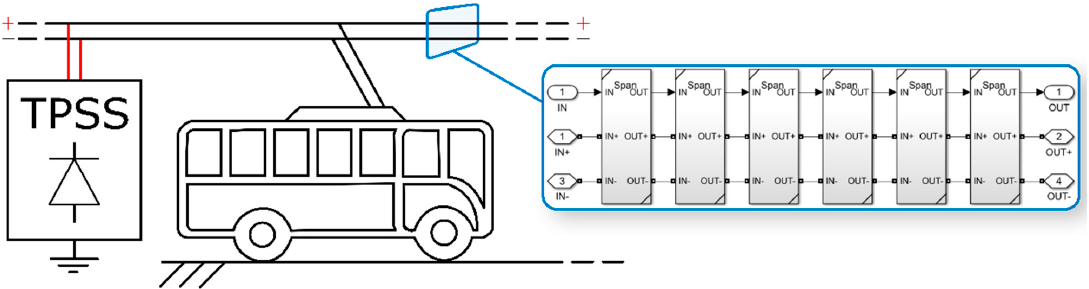
Figure 5. Catenary modeling with Subsystem Reference blocks.